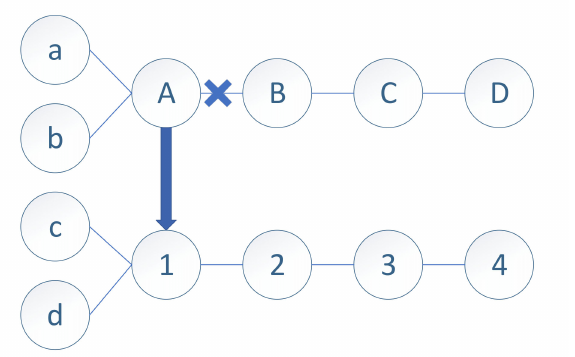
Figure 6. The alternative link